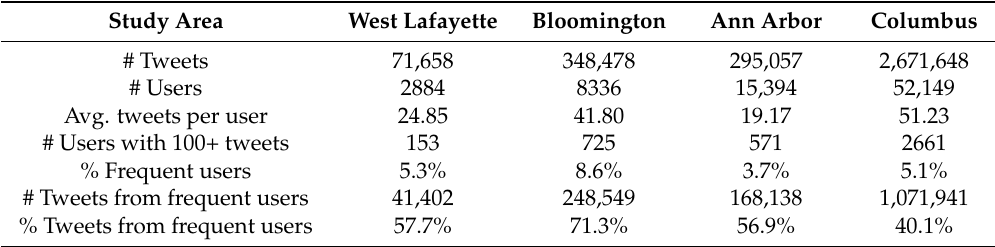
Table 2. Number of tweets, users, and frequent users with more than 100